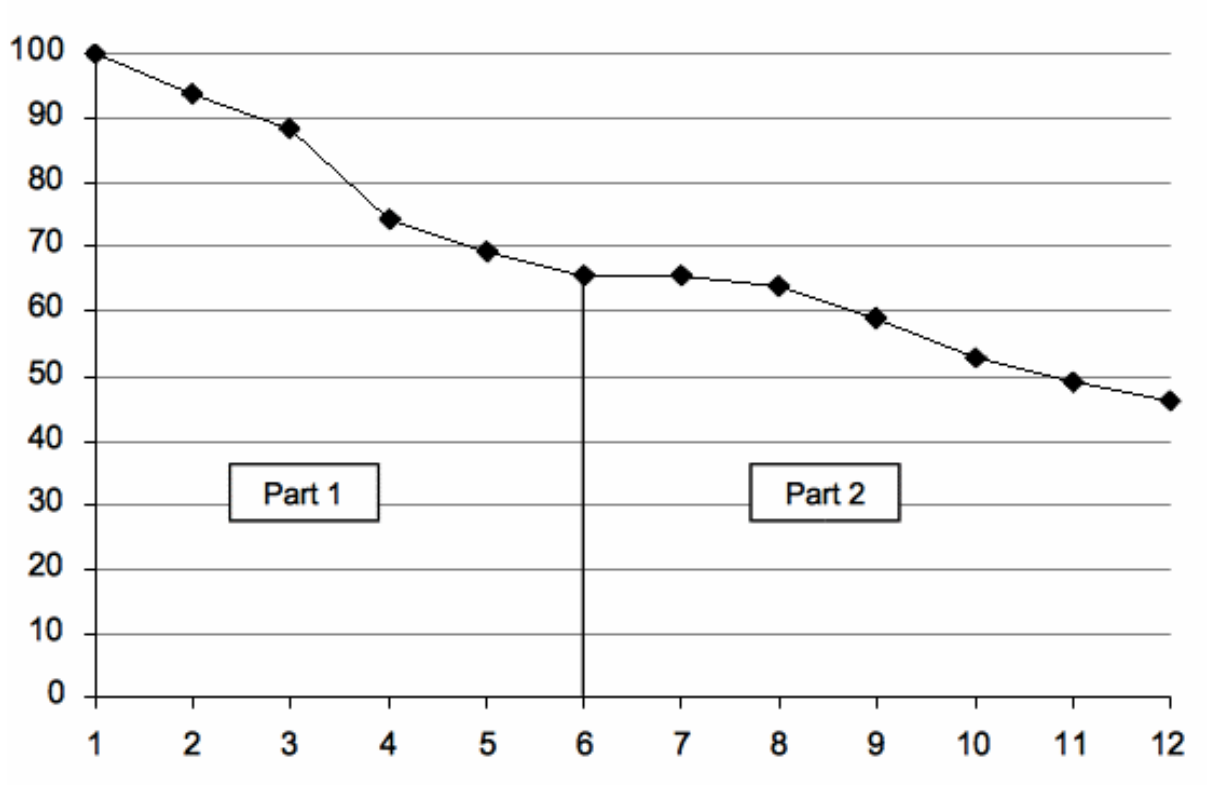
Figure 4. Attrition curve e-therapy group: proportion participants by number of